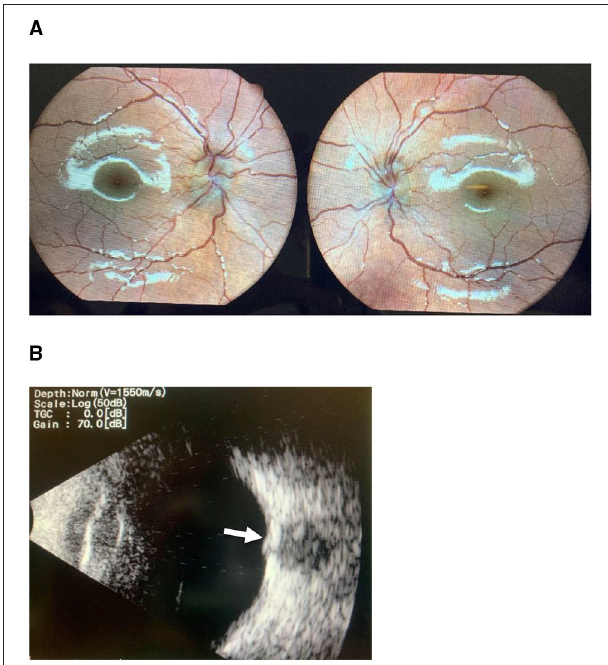
FIGURE 1 | (A) Optic disc photography demonstrates papilledema. (B) B-scan ultrasonography confirming the presence of ahyper-reflective optic disc druse (arrow) in the same patient.